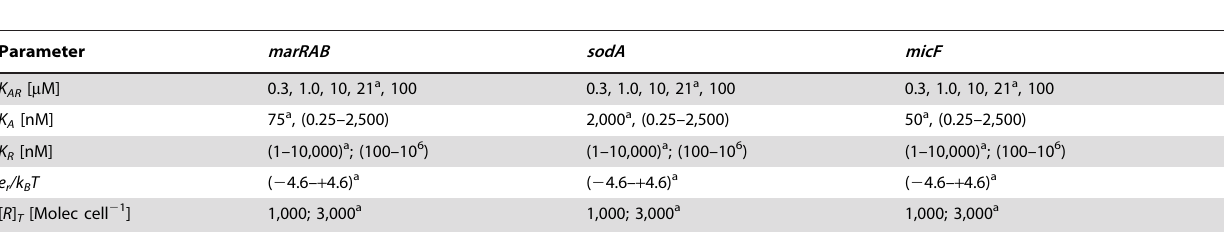
Table 1. Parameter values used to model activation of marRAB , sodA , and micF promoters by MarA.